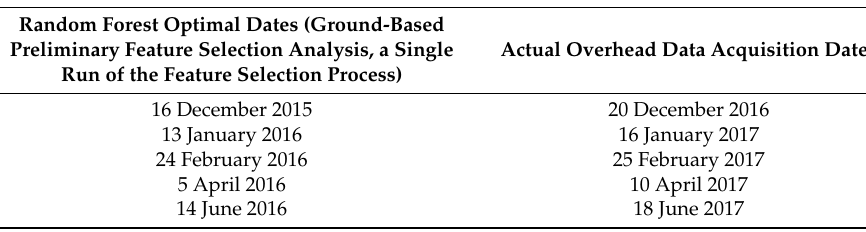
Table 3. Overhead data acquisition dates in the Mata (M) site.